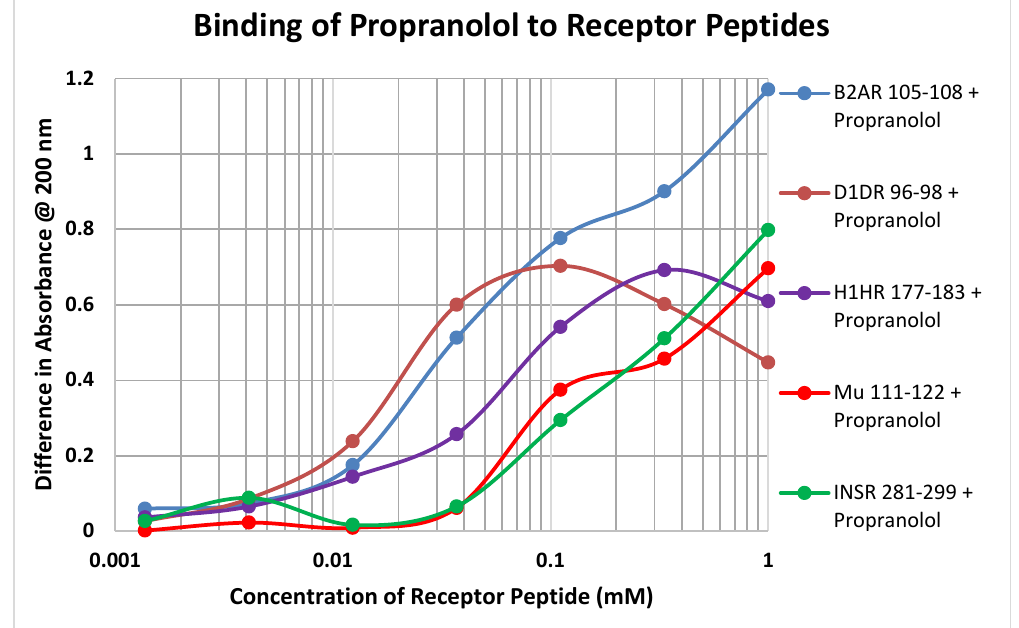
Figure 7. Binding of propranolol to receptor peptide derived from the beta 2 adrenergic receptor (B2AR), dopamine 1 receptor (D1DR), histamine 1 receptor (H1HR), mu opioid receptor (Mu) and insulin receptor (INSR). Additional data in Tables 1 and 2.